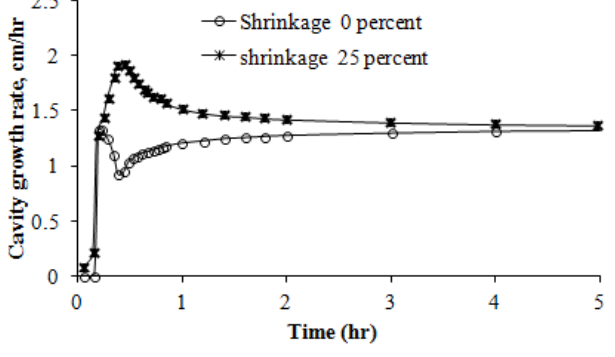
Figure 41. Effect of the shrinkage on the cavity growth rate [79].